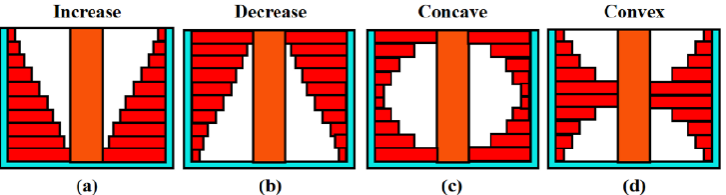
Figure 8. Distributions of partially filled nanogaps: ( a ) increase, ( b ) decrease, ( c ) concave ( d ) convex.